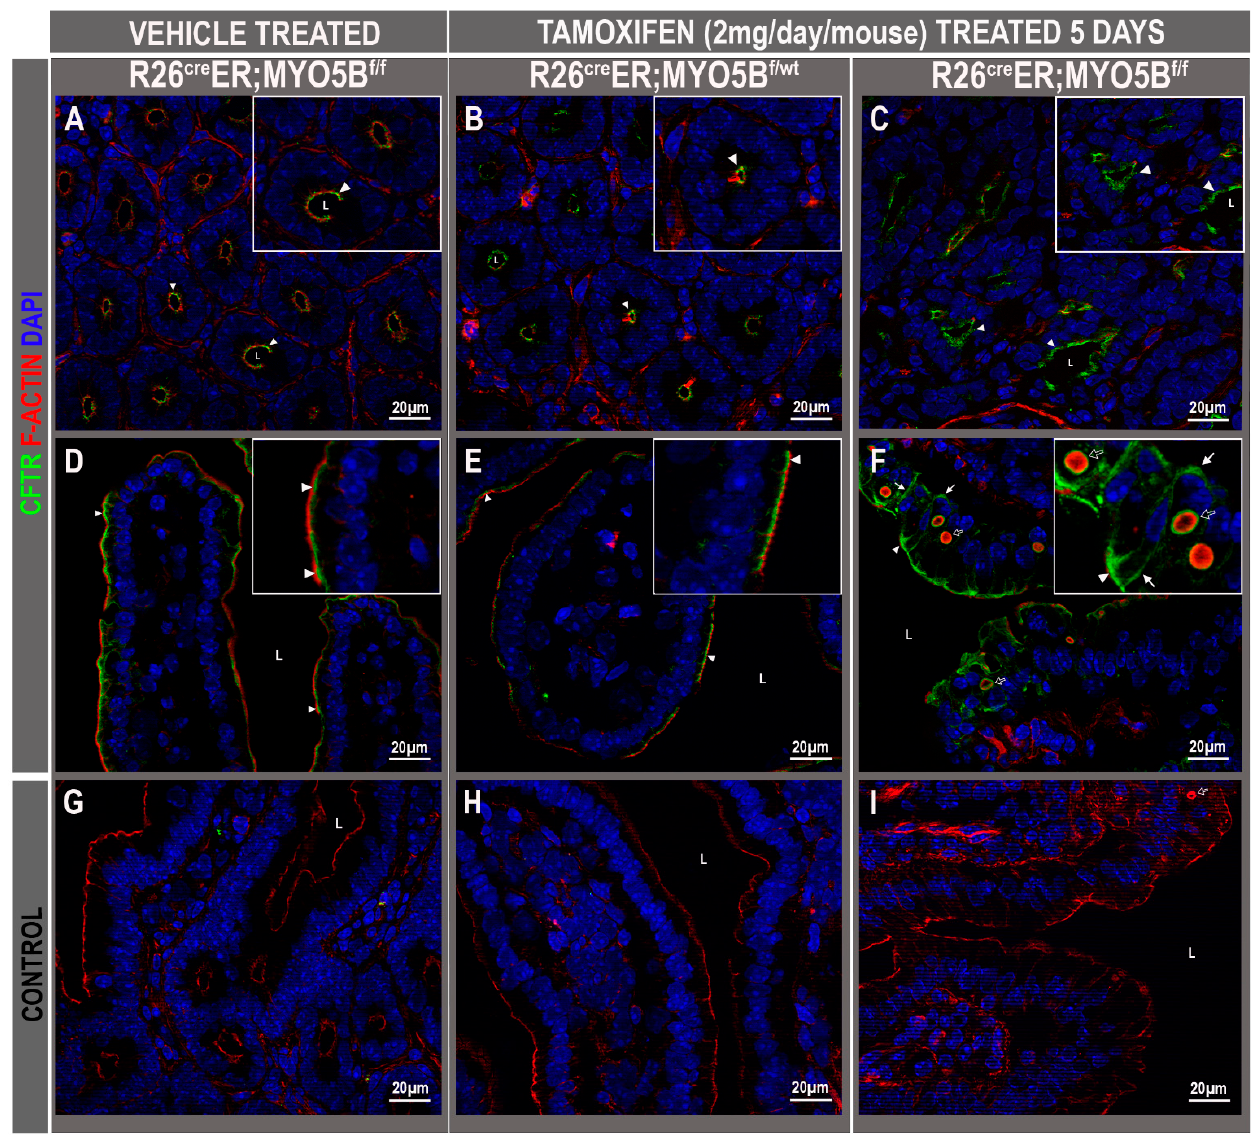
Figure 5. CFTR is preserved on the apical membrane and redistributed to the basolateral membranes of villus enterocytes in R26 Cre ER;MYO5B f/f (cMYO5bKO) jejunum. Immunofluorescence localization of CFTR and F-actin in immunolabeled cryostat sections from vehicle-treated R26 Cre ER;MYO5B f/f , or tamoxifen (2 mg/day/mouse)-treated R26 Cre ER;MYO5B f/wt and R26 Cre ER;MYO5B f/f mice at day 5. Tissue sections from jejunum were immunolabeled for CFTR (green), F-actin (red), and DAPI (blue). ( A , D , G ) Images taken from vehicle-treated R26 Cre ER;MYO5B f/f (Homozygous) mice; ( B , E , H ) are from tamoxifen-treated R26 Cre ER;MYO5B f/wt (Heterozygous) mice; ( C , F , I ) are from tamoxifen- treated R26 Cre ER;MYO5B f/f (Homozygous) mice; ( G – I ) are negative control staining with secondary antibody only; ( A – C ) show CFTR staining in crypts, and ( D – F ) show CFTR staining in villus. The normal apical domain localization of CFTR (white arrowheads) in the villus of vehicle-treated homozygous ( D ) or tamoxifen-treated heterozygous jejunum ( E ), is redistributed to the basolateral membranes in villus enterocytes of tamoxifen-treated homozygous mouse jejunum ( F , insert, white arrows). Several F-actin positive microvillus inclusions (MIs) (black arrows), decorated with CFTR on the outer membranes are detected in the cytoplasm of tamoxifen-treated R26 cre ER;MYO5B f/f mouse jejunal villus enterocytes. Inserts in upper right show higher power images of indicated areas in the lower power images. Scale bars: 20 µ